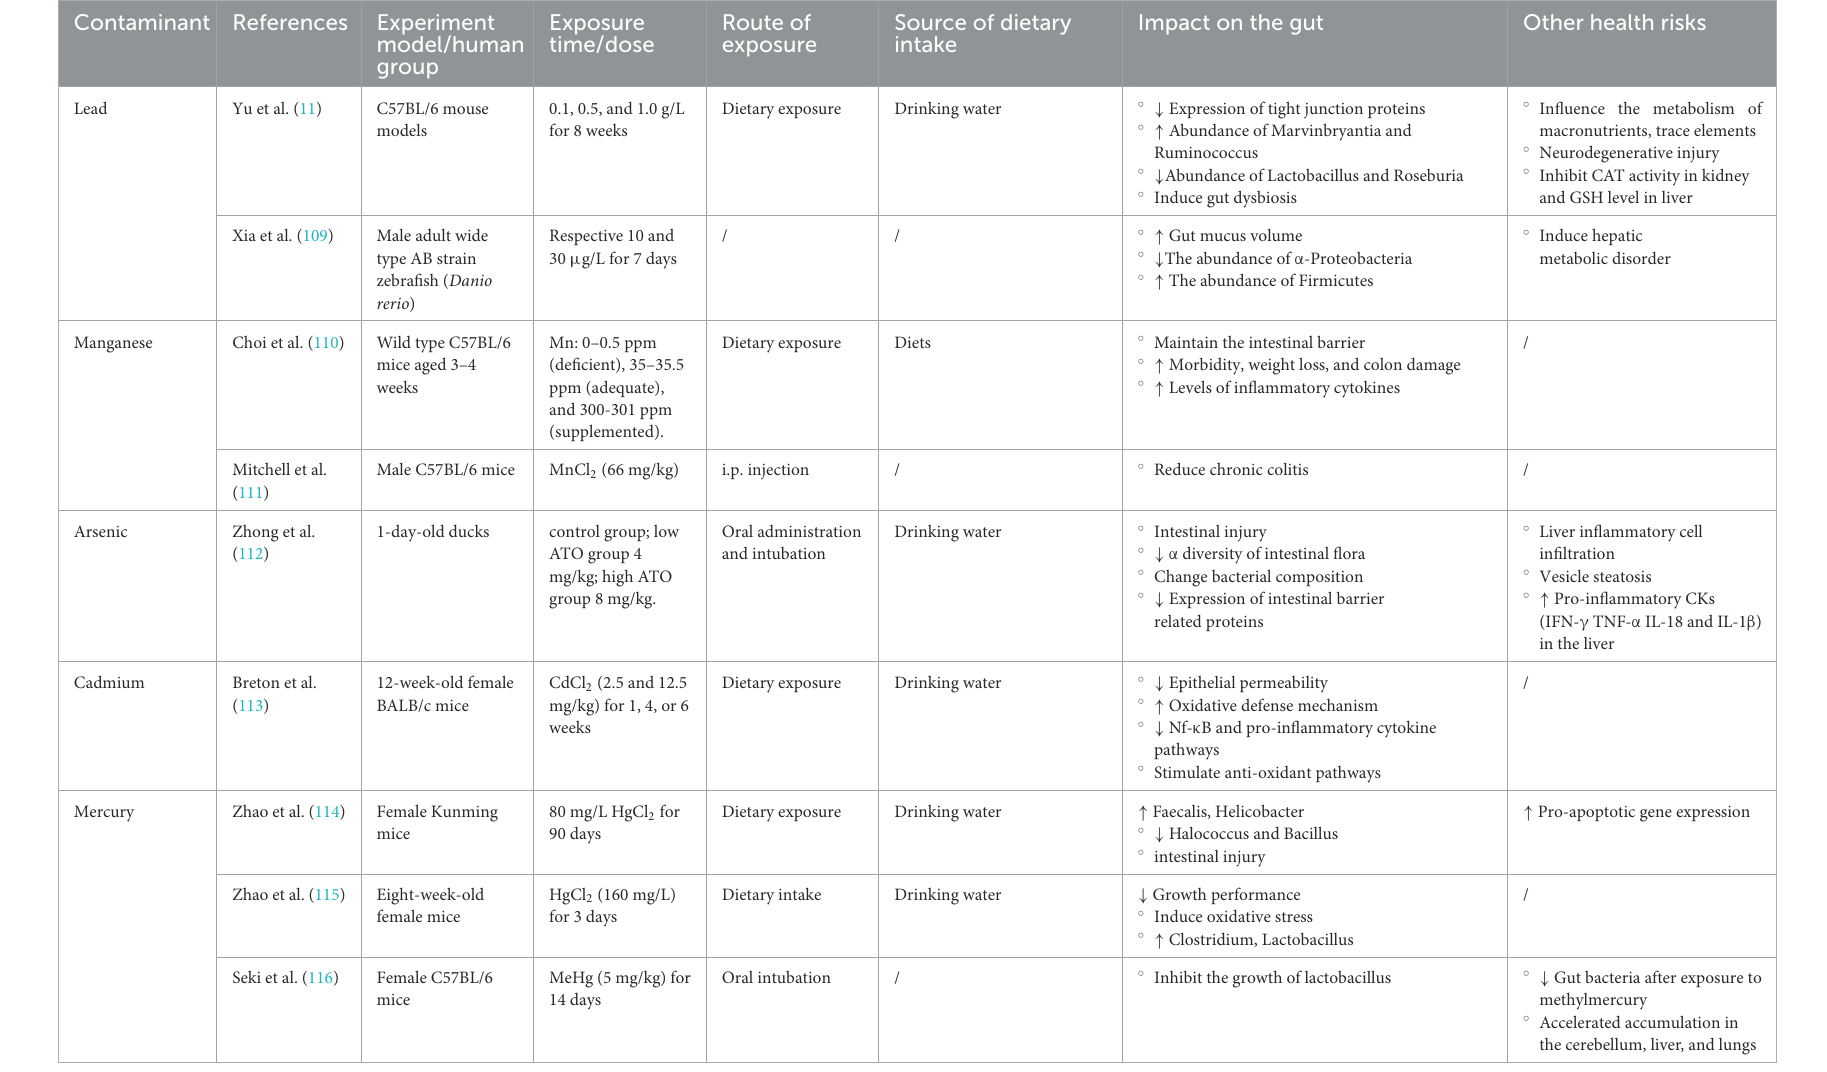
TABLE 4 Adverse health effect of heavy metals in inflammatory bowel